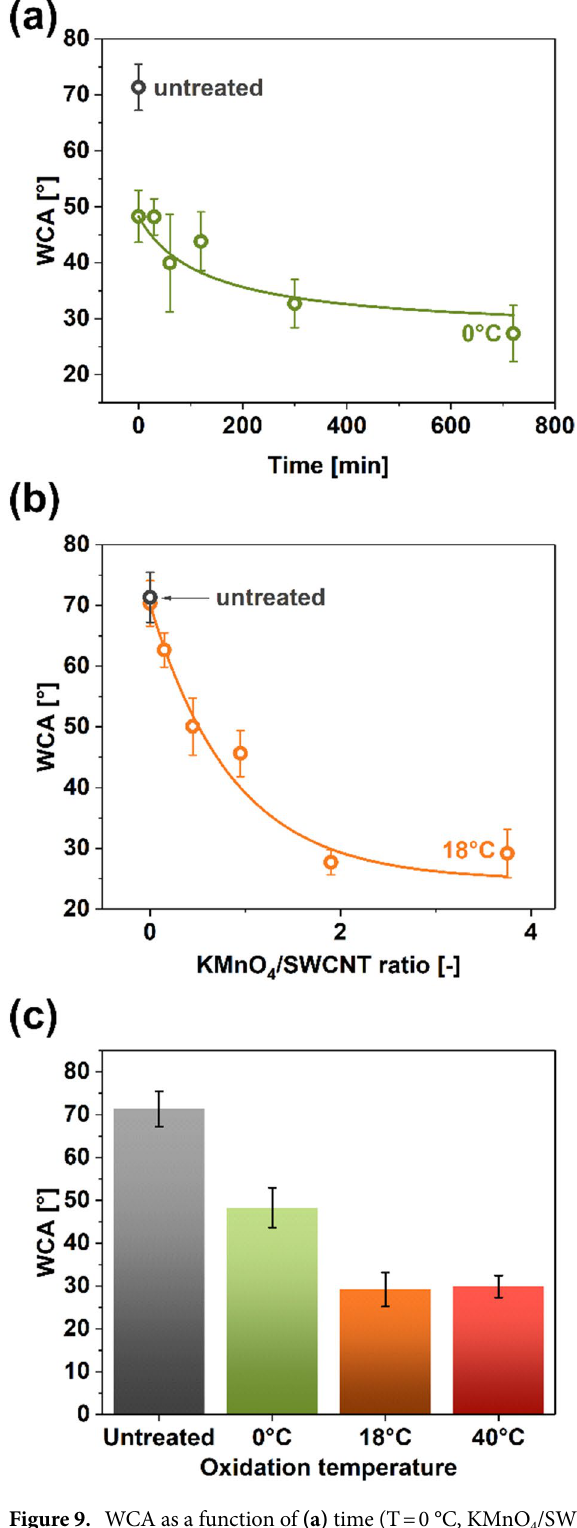
Figure 9. WCA as a function of (a) time (T = 0 °C, KMnO 4 /SWCNT = 7.5), (b) KMnO 4 /SWCNT ratio (T = 18 °C, t = 0 min), and (c) temperature (KMnO 4 /SWCNT = 7.5, t = 0